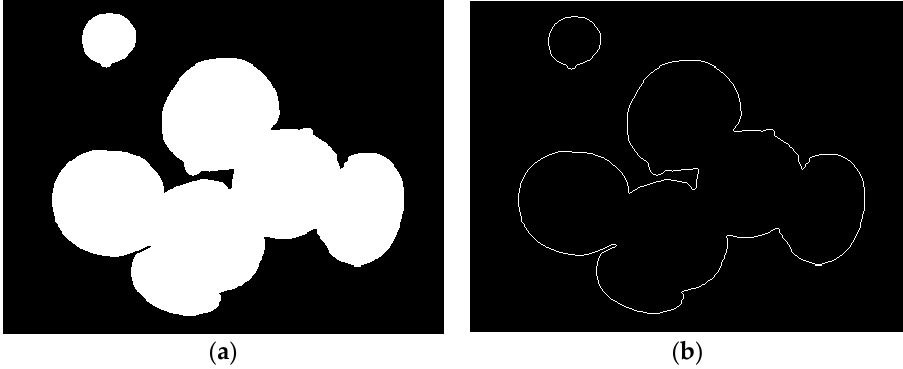
Figure 4. Agaricus bisporus area and outline. ( a ) Image after open operation; ( b ) edge detection.